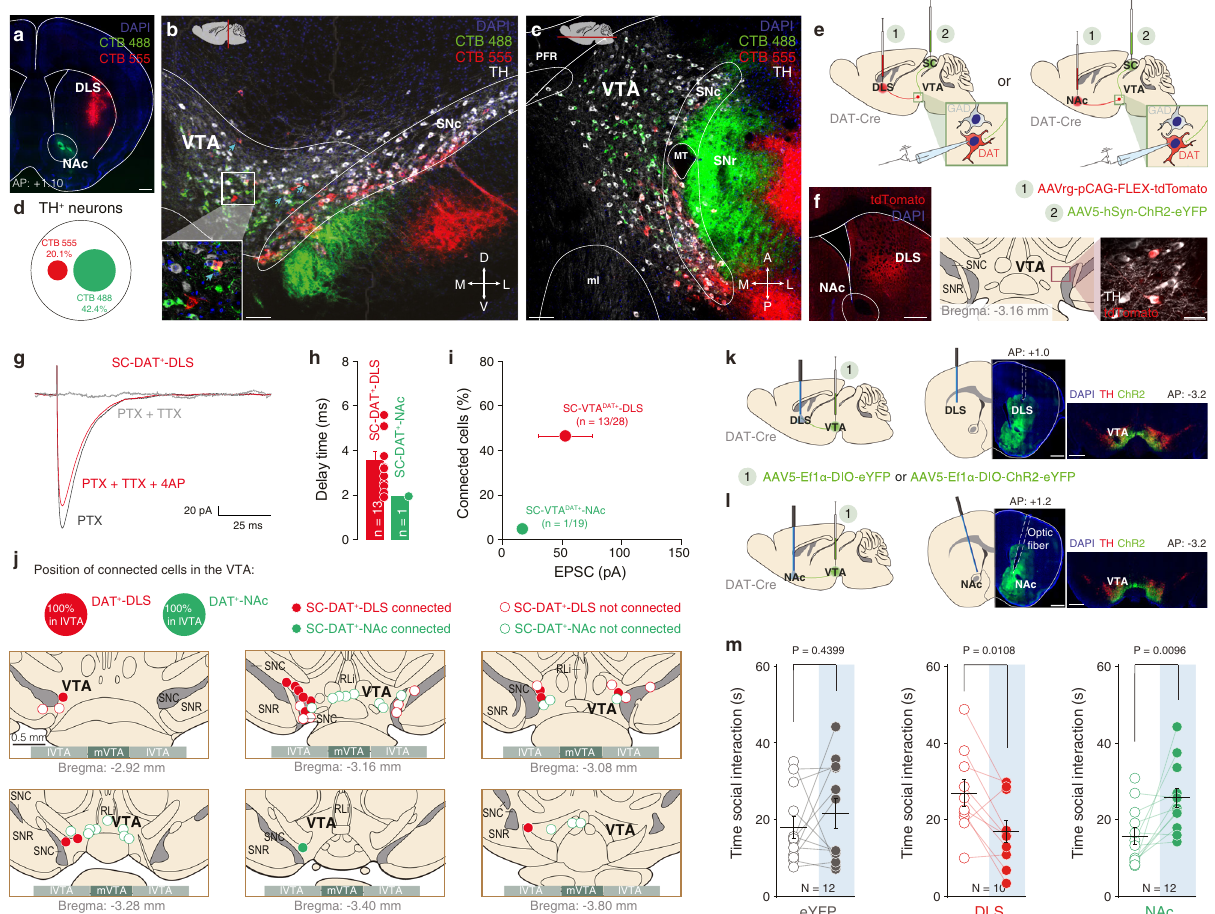
Fig. 7 SC is mainly connected to VTA DAT + neurons which project to DLS. a Representative image of the NAc and DLS in coronal slice infected with the CTB-488 and CTB-555 (scale bar 500 µ m. This experiment was reproduced at least three times). b Coronal plane image of the VTA with TH staining (white) and infected cells projecting to the NAc or DLS (scale bar = 100 µ m. This experiment was reproduced at least three times). c Horizontal plane image of the VTA with TH staining (white) and infected cells projecting to the NAc or DLS (scale bar = 100 µ m. This experiment was reproduced at least three times). d Proportion of TH + and either TH + /CTB-488 + (NAc-projecting VTA DAT + neurons) or TH + /CTB-555 + (DLS-projecting VTA DAT + neurons). e Schema of injections in DAT-Cre mice. The SC was infected with AAV5-hSyn-ChR2-eYFP and the NAc or the DLS with the AAVrg-pCAG- FLEX-tdTomato. Whole-cell patch was then performed in DAT + neurons projecting to two different regions. f Left panel: Representative image of the AAVrg-pCAG-FLEX-tdTomato site of injection in the DLS (scale bar = 500 µ m). Right panel: example of DAT + neurons projecting to DLS (scale bar = 20 µ m). This experiment was reproduced at least three times. g Example traces of optogenetically elicited excitatory postsynaptic currents (EPSCs) in VTA DAT + neurons projecting to DLS in presence of PTX, TTX, and 4AP. h Delay time of the EPSCs for VTA DAT + -NAc or DAT + -DLS neurons. i Quanti fi cation of connected cells from SC onto VTA DAT + -NAc or DAT + -DLS neurons in relation of the amplitude of EPSCs. The VTA DAT neurons receiving projections from the SC are mainly projecting to the DLS with the highest current amplitude. j Position of some patched VTA DAT + -NAc or DAT + -DLS neurons. SC-VTA DAT + -DLS connected neurons are mainly in the lateral part of the VTA (lVTA). k Left panel: Schema of injections sites in the VTA of DAT-Cre mice with AAV5-Ef1 α -DIO-eYFP or AAV5-Ef1 α -DIO-ChR2-eYFP, and optic fi ber implantation above the DLS. Middle panel: representative image showing the fi ber optic ’ s track in the DLS (scale bar = 500 µ m). Right panel: representative image of the site of injection in the VTA (scale bar = 500 µ m). Similar viral expression and OF location were observed in all the mice that performed the experiment which results are shown in Fig. 7l. l Left panel: Schema of injections sites in the VTA of DAT-Cre mice with AAV5-Ef1 α -DIO-ChR2-eYFP or AAV5-Ef1 α -DIO-eYFP, and optic fi ber implantation above the NAc. Middle panel: representative image showing the fi ber optic ’ s track in the NAc (scale bar = 500 µ m). Right panel: representative image of the site of injection in the VTA (scale bar = 500 µ m). Similar viral expression and OF location were observed in all the mice that performed the experiment which results are shown in Fig. 7l. m Left panel: VTA DAT + -NAc eYFP and VTA DAT + -DLS eYFP mice do not change time of social interaction between the two stimulation conditions. Paired t -test two-sided (t (11) = − 0.8013). Middle panel: VTA DAT + -DLS ChR2 mice decrease the time of social interaction during light ON condition. Paired t -test two-sided (t (11) = 3.2015). Right panel: VTA DAT + -NAc ChR2 mice increase the time of social interaction during light ON condition. Paired t -test two-sided (t (11) = − 2.8177). N, n indicate number of mice and cells respectively. All the data are shown as the mean ± s.e.m. as error bars. Source data are provided as a Source Data fi le.